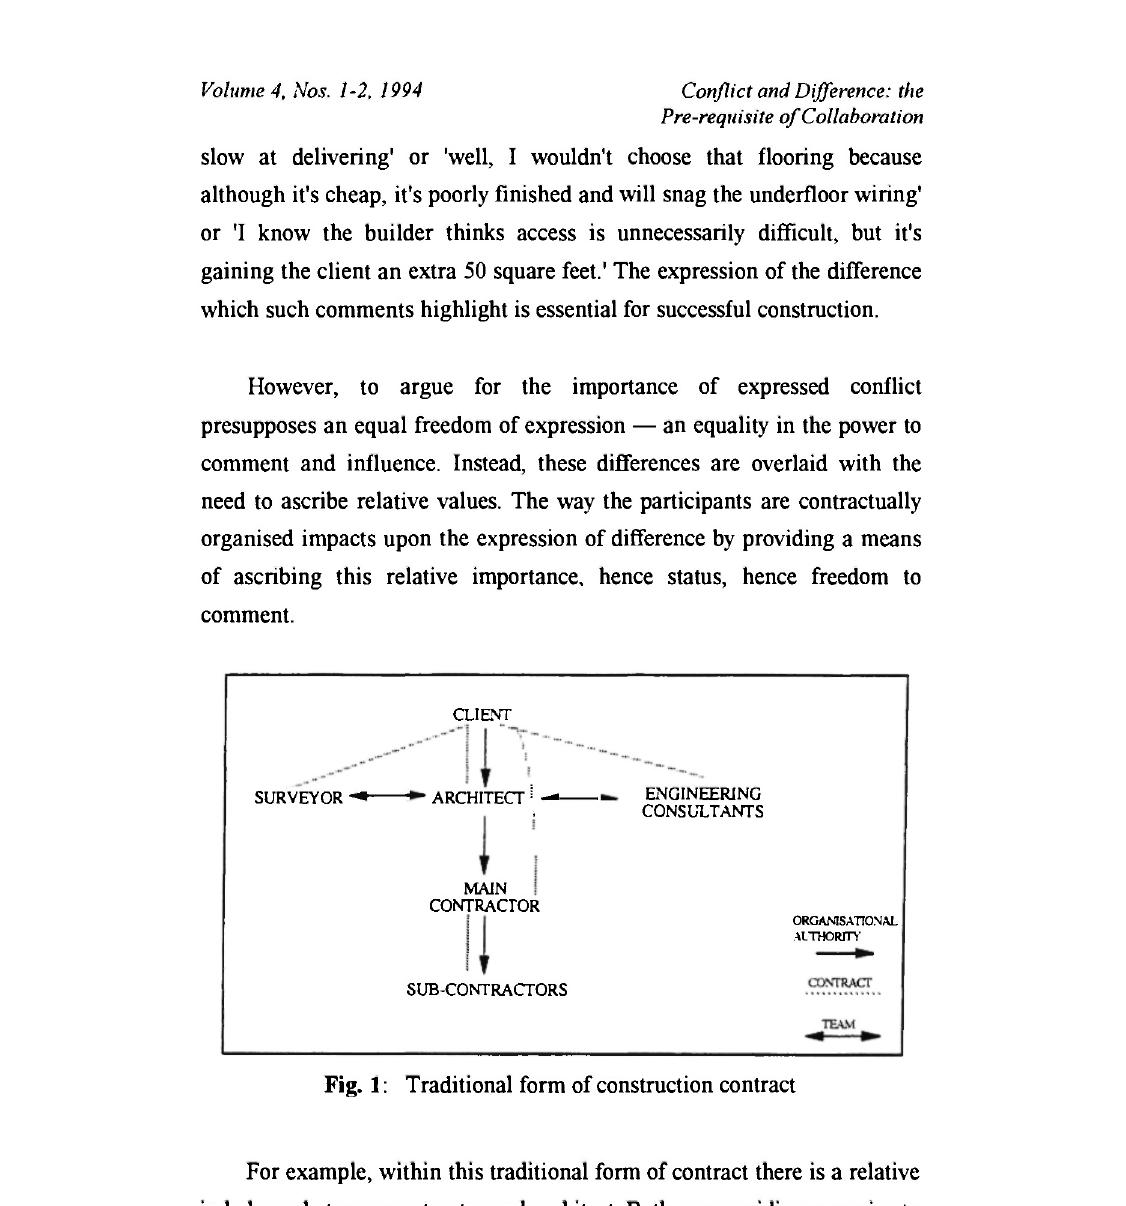
Fig. 1: Traditional form of construction